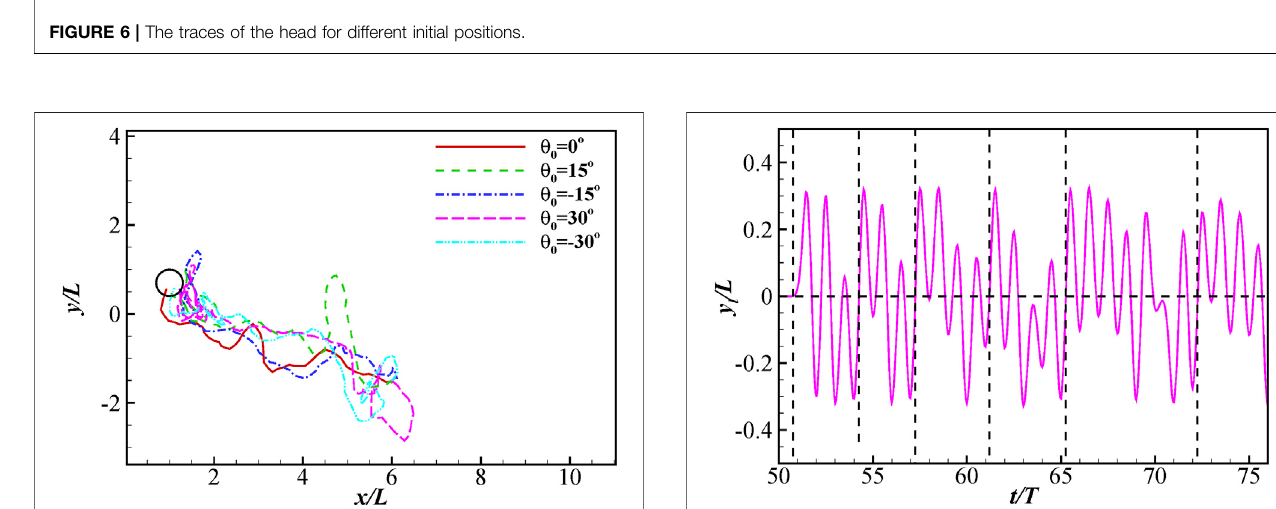
apping will accelerate this process. Therefore, the fi sh adopts a